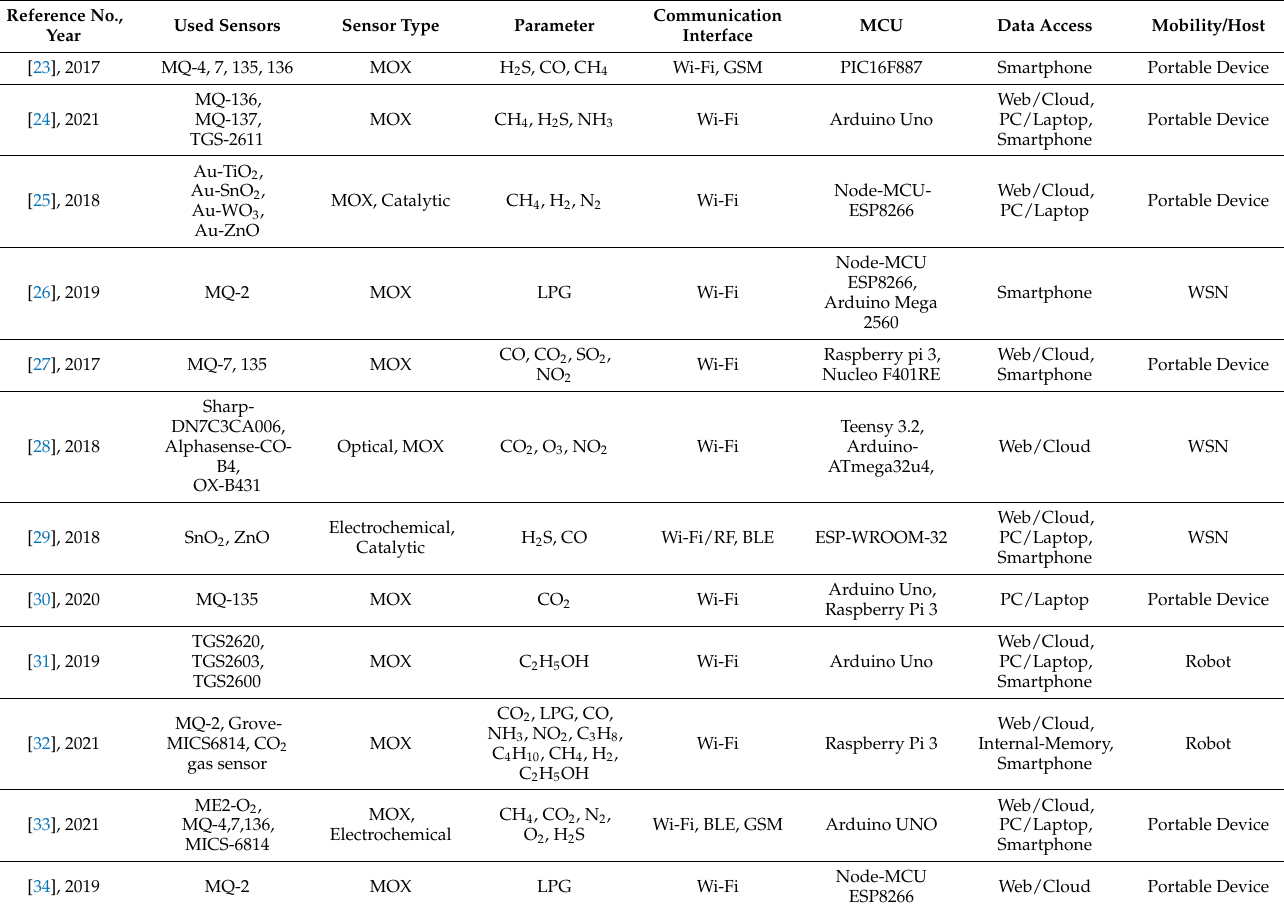
Figure 6. Distribution of the mobility type of the proposed systems. We summarized the commercial name, type of sensing elements, the parameter measured, used communication modules, the main processing unit, the method of data access, and the mobility of the included systems in Table 3. Table 3. Summary of mobile hazardous gases detecting and alarming systems.